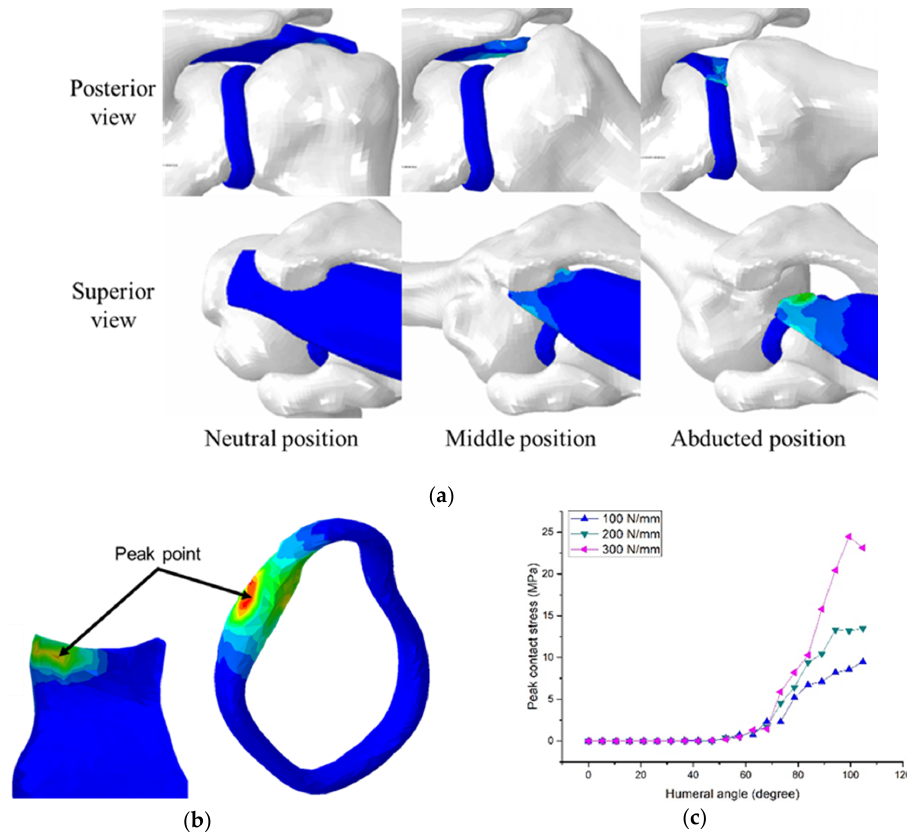
Figure 6. The finite element simulation result by the proposed method: ( a ) Screenshot of the finite element simulation result; ( b ) The point for peak contact stress measurement on the labrum; ( c ) Stress change curve between supraspinatus and labrum according to humeral angle.